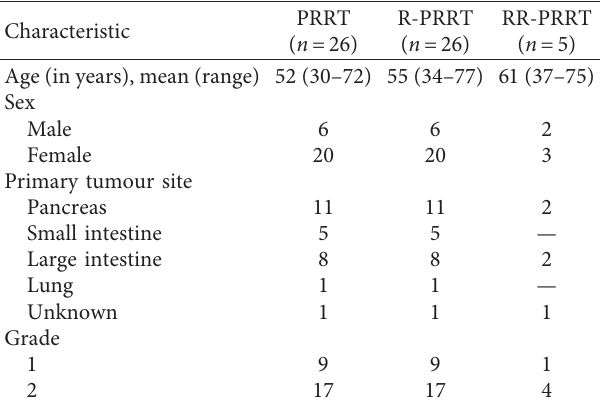
Table 1: Patient characteristics.